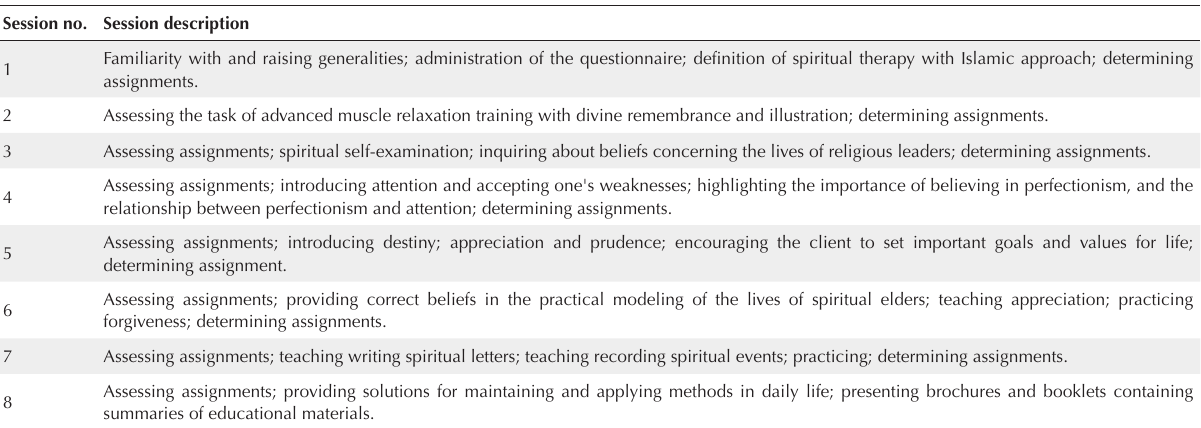
Table 2. Summary of Islamic-based spiritual therapy sessions Session no. Session description